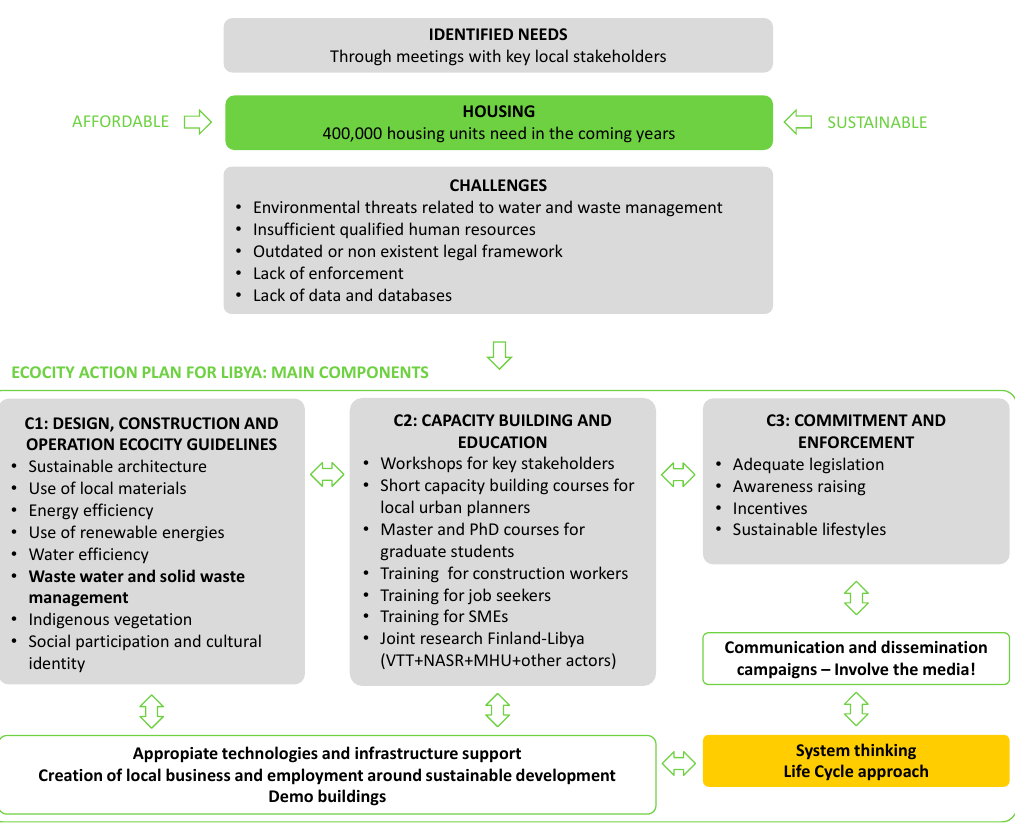
Figure 5. EcoCity Action Plan for Libya. (Ministry of Housing and Utilities of Libya, VTT Technical Research Centre of Finland Ltd.)